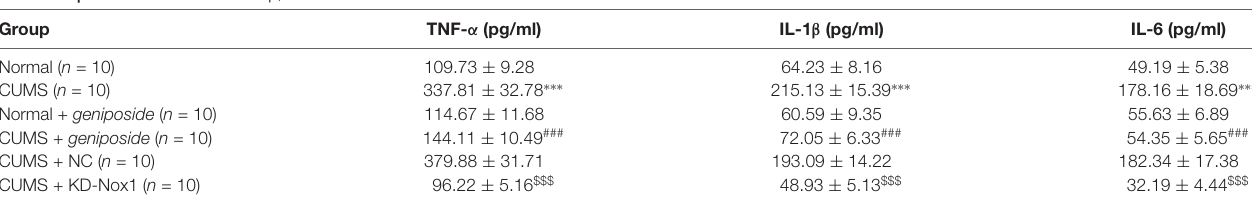
TABLE 4 | The serum levels of IL-1 β , IL-6 and TNF- α in mice. Group TNF- α (pg/ml) IL-1 β (pg/ml) Normal ( n =